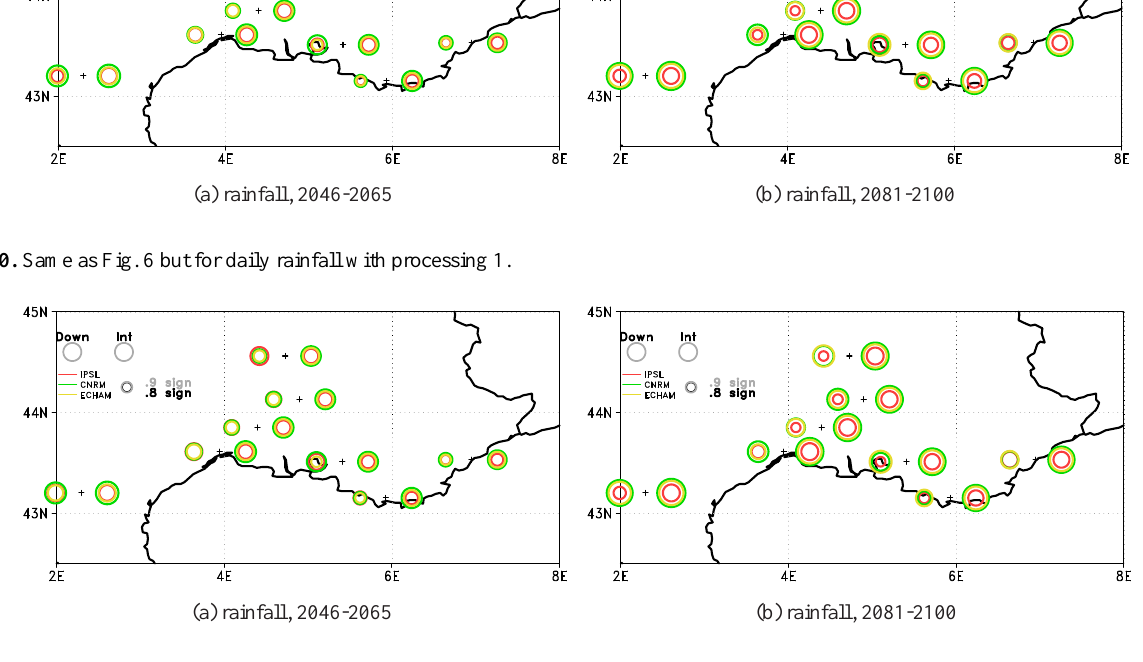
Fig. 11: Same as Fig. 6 but for daily rainfall with processing 2.